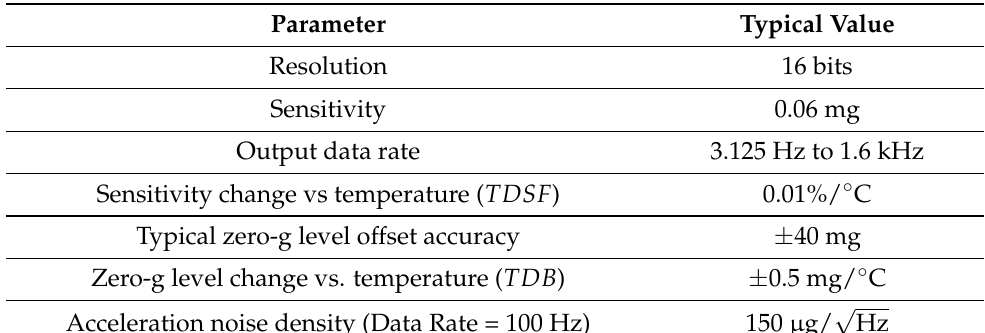
Table 1. Typical characteristics of the LIS3DSHTR MEMS accelerometer in the ± 2 g range configura- tion (FS bit set to